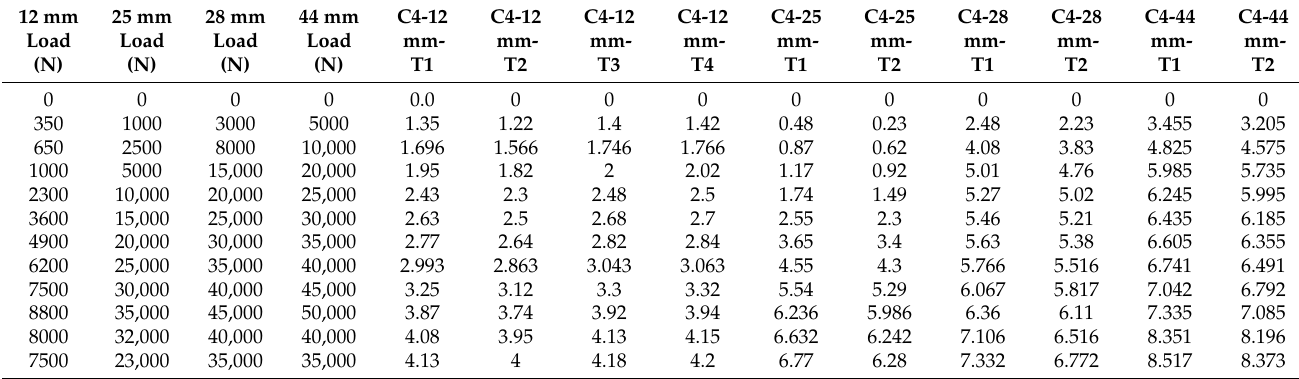
Table A4. Peak force and associated displacement for punch test cell 4